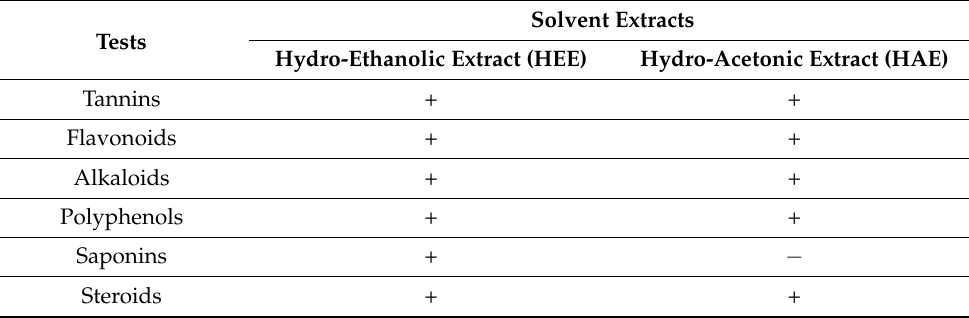
Table 1. Secondary metabolites presented in the studied